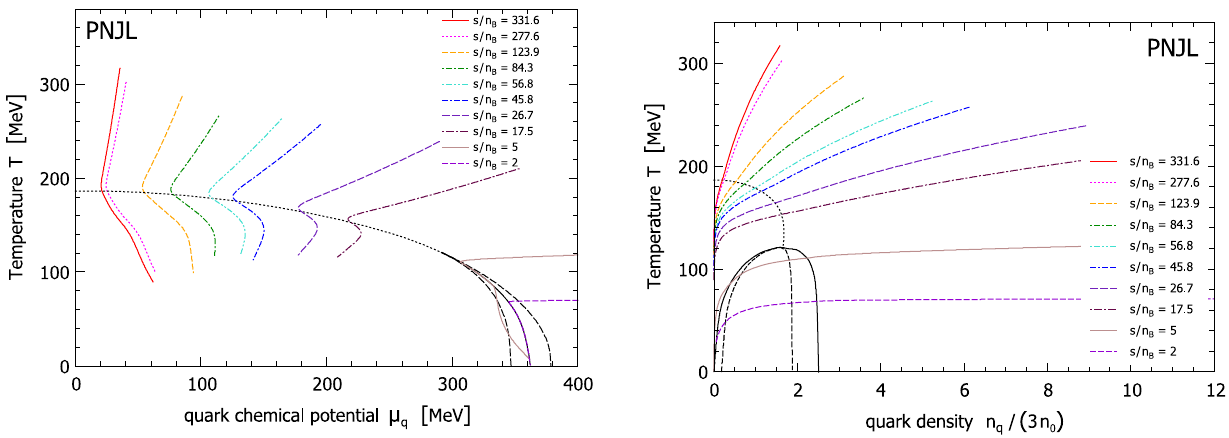
Fig. 1 Phase diagram of the PNJL model expressed in terms of the chemical potential (left) and of the baryon density (right). The black, dotted lines represent the chiral crossover, identified through the inflec- tion point of the effective mass of light quarks. The continuous, black curves represent the first-order transition lines. The black, dashed spin- odal lines represent the boundaries of the regions where a homogeneous